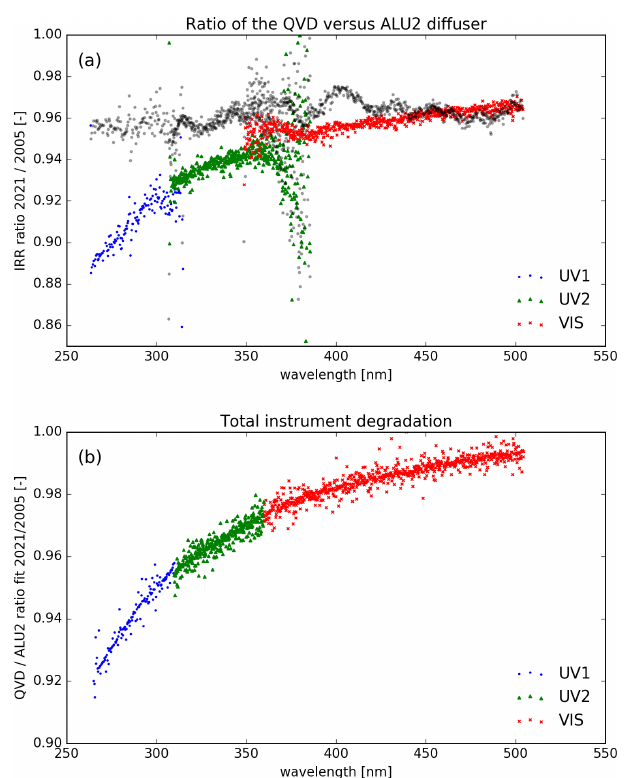
Figure 4. Total instrument degradation observed through the QVD over the period 2005–2021 is shown in (a) for all wavelengths. The UV1, UV2, and VIS data are shown in blue dots, green triangles, and red crosses, respectively. In gray circles the total instrument degradation through the regular ALU1 diffuser is shown, which is a representative measure of the folding-mirror change and spectrom- eter change. The larger spread is caused by diffuser speckle that is more prominent in the aluminum diffusers than in the QVD. Clearly there is an overall 4% degradation with no strong wavelength de- pendence; for the ALU2 diffuser this dependence is even lower. Panel (b) shows the ratio between the QVD and ALU2 backup diffuser. This isolates the QVD components from the common components in the optical path and clearly shows the wavelength- dependent degradation of the